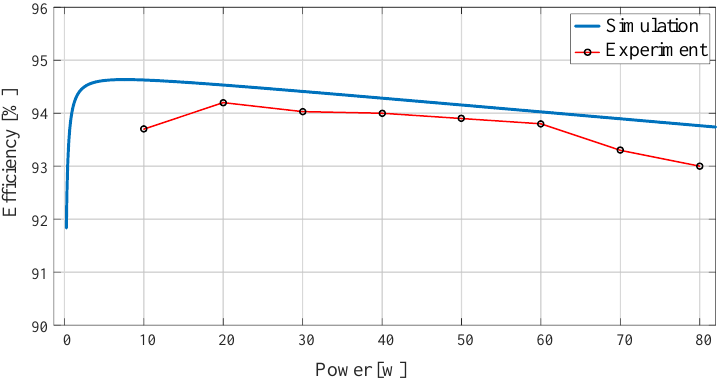
Figure 14. The efficiency of the hardware prototype and the simulated